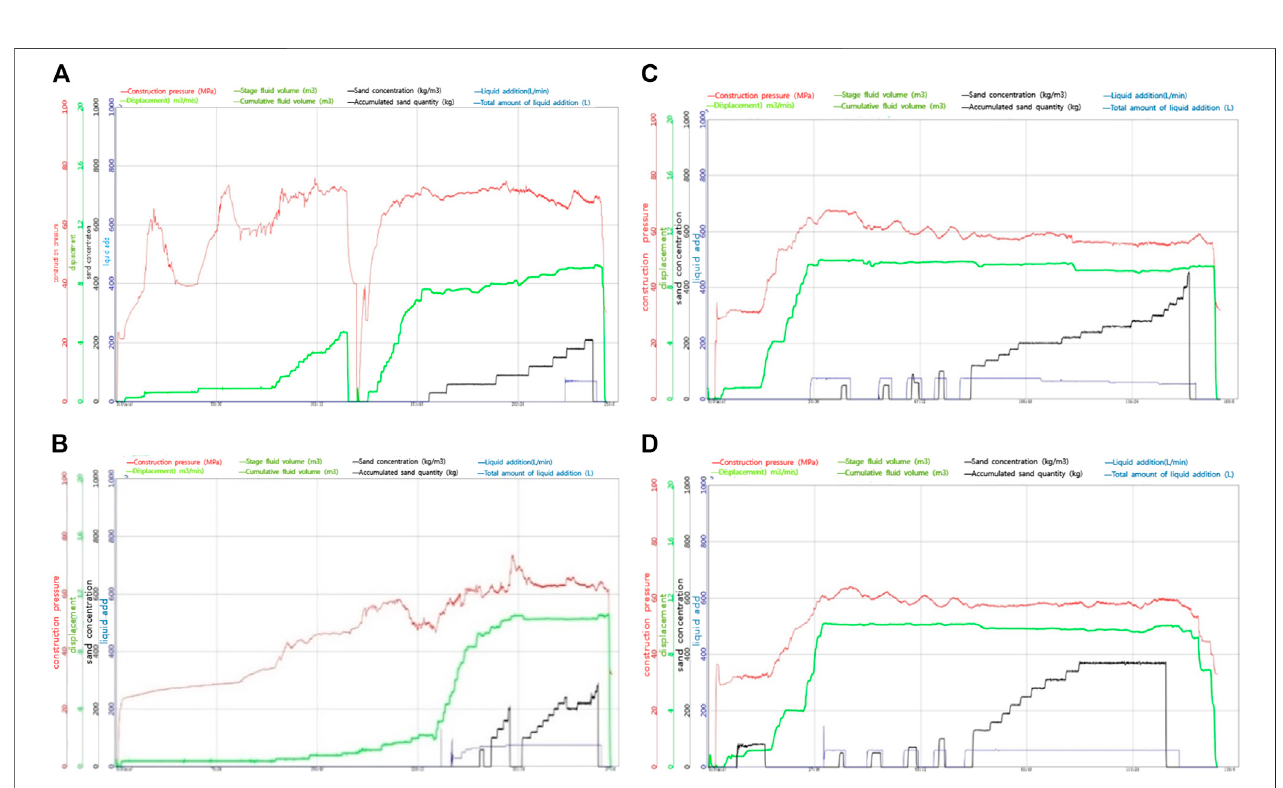
FIGURE4|(A) First-stagefracturingoperationgraphofthenewfractureinwellM3; (B) Second-stagefracturingoperationgraphofthenewfractureinwellM3; (C) Third-stage fracturing construction graph of the new fracture in well M3; (D) Fourth stage fracturing construction graph of the new seam in well